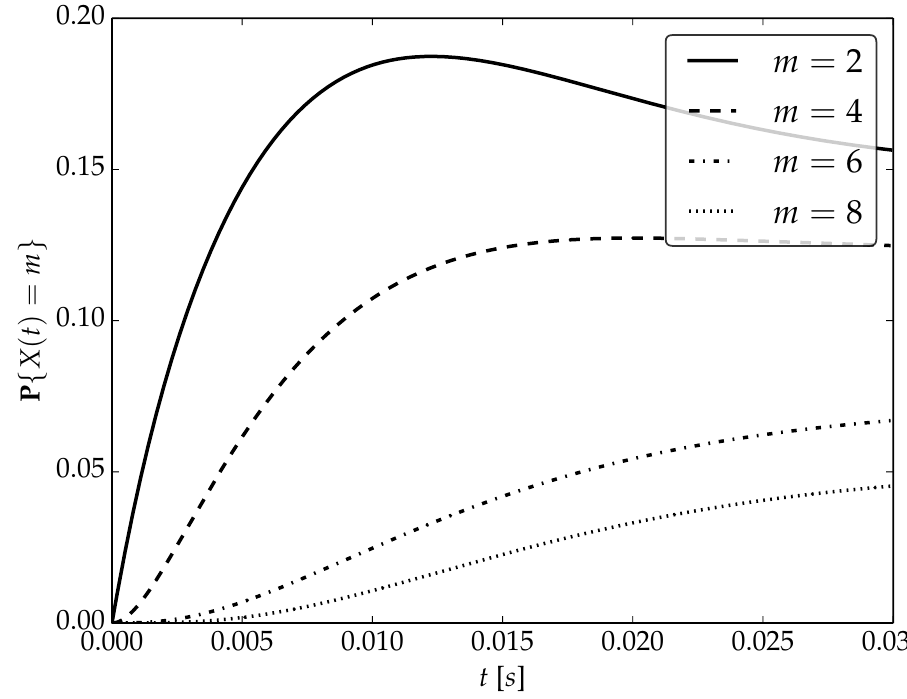
Figure 7. Transient distributions P { X ( t ) = m } for N = 4, batch distribution P 2 and ρ =